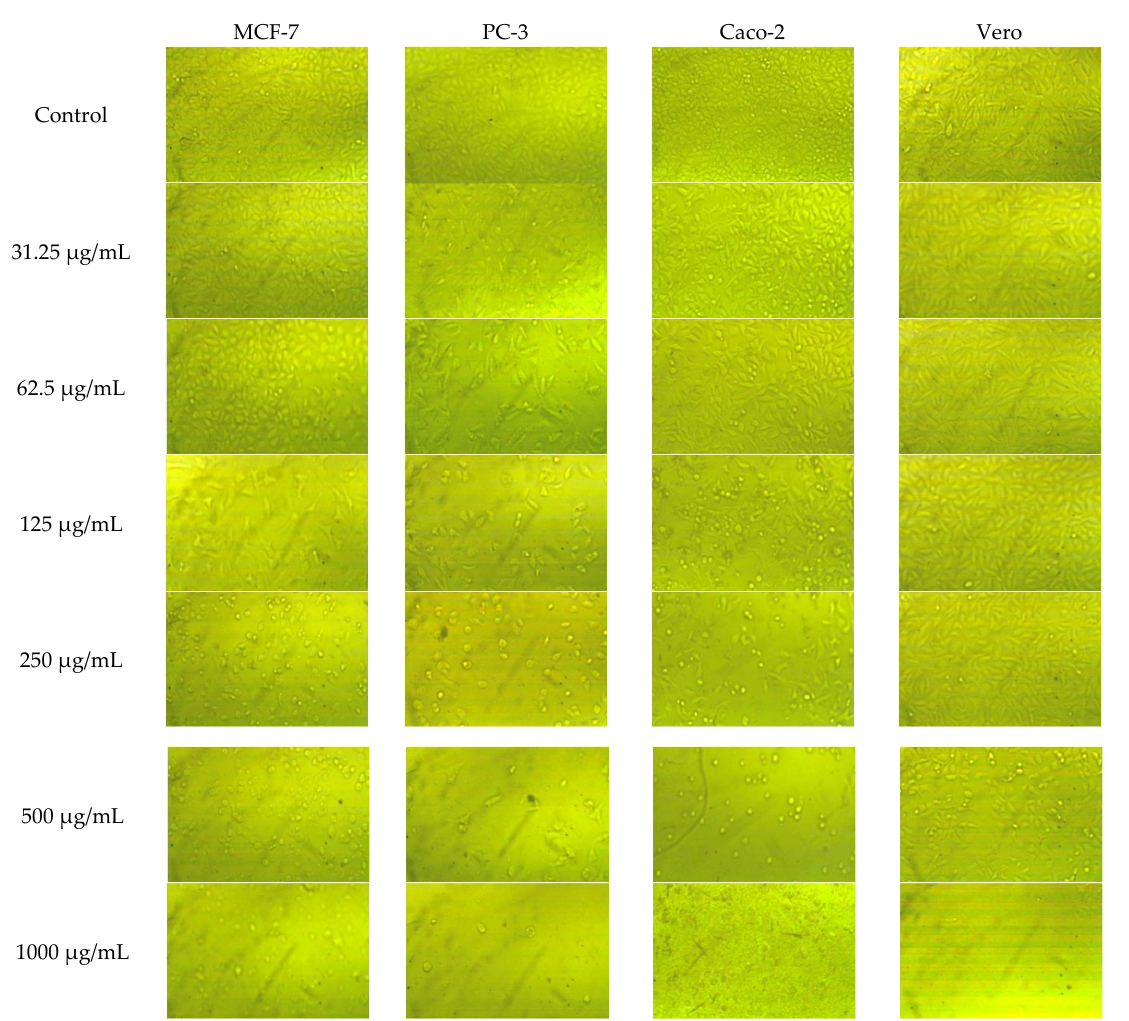
Figure 3. Morphology of MCF-7, PC-3, Caco-2 and Vero cells after 48 h from the treatment with different concentrations of A. vulgaris root extract. Pictures were taken using a Reichert-Jung inverted biological microscope, series 1820 Biostar with a 10× objective coupled with MEM1300 microscope USB digital camera. Table 6. IC 50 (µg/mL) and selectivity index of A. vulgaris root extract against different cell lines. IC 50 (μg/mL)